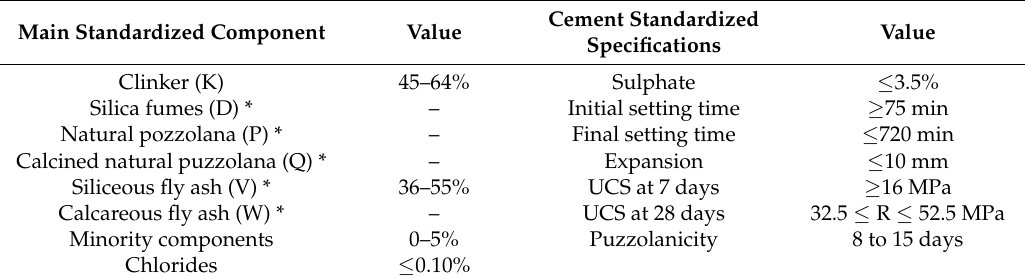
Table 1. Properties of cement